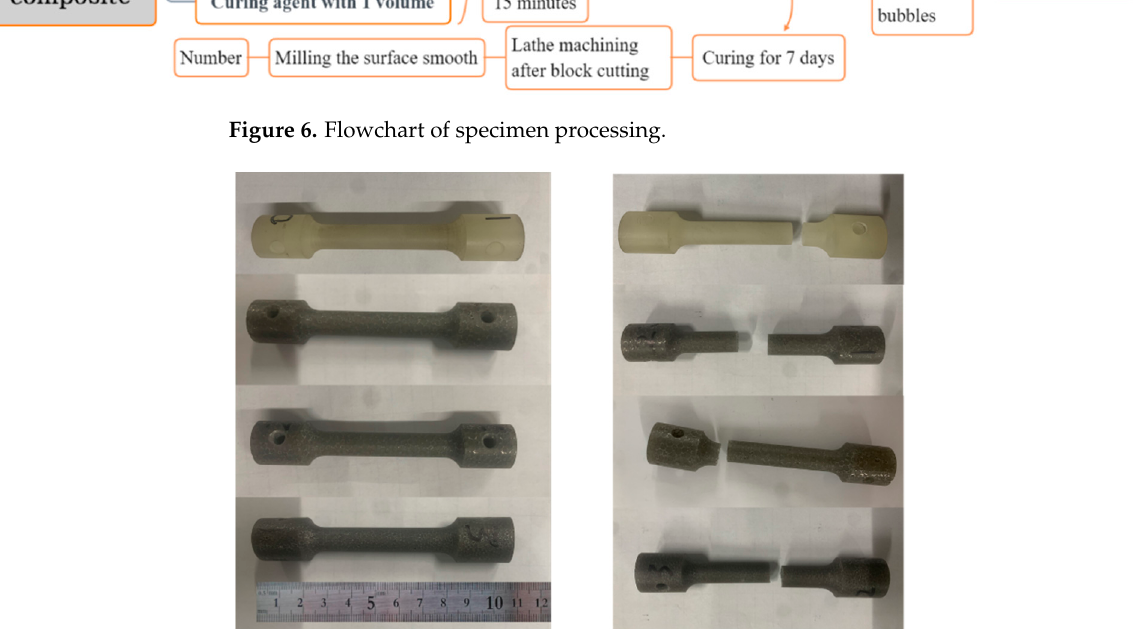
Figure 6. Flowchart of specimen processing.